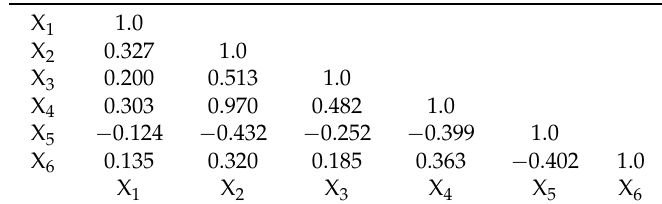
Table 3. Correlations for independent